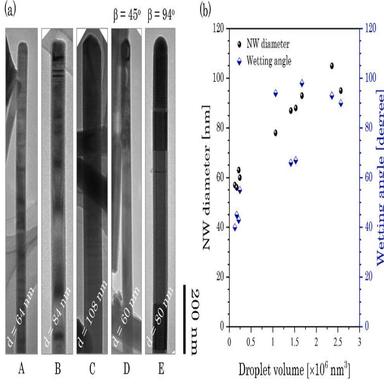
a) TEM image of GaAs NWs having different diameters and wetting angles, b) the dependence of wetting angle on NW diameter.